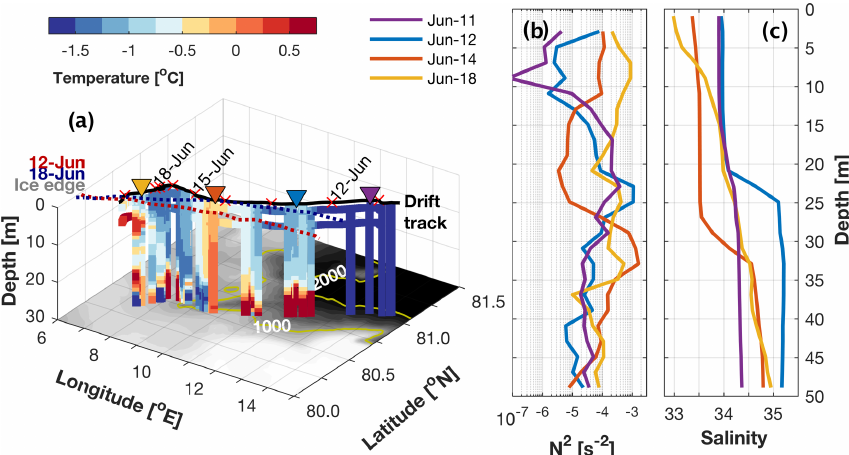
Figure 3. Ocean and sea ice conditions over the course of the drift. (a) Drift track between 10 and 19 June (black) with daily ticks (crosses). Conservative temperature (colors) data are derived from a combination of vertical MSS profiles in the upper 30m and TIC time series measurements from 1 and 5m. The ice edge (50% concentration) is shown for 12 and 18 June. Water depth is indicated in shading, with yellow isolines at 1000 and 2000m. Triangles mark the location of (b) four profiles of stratification ( N 2 ) in the upper 50m.